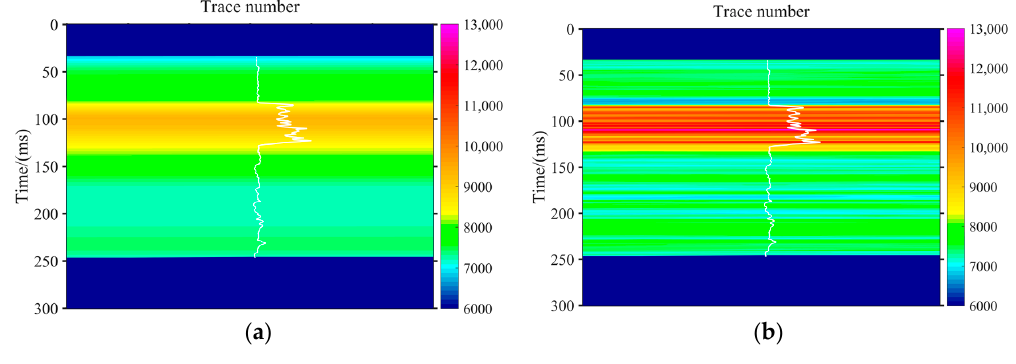
Figure 7. The impedance near the well log. ( a ) Initial model and ( b ) GMHDD.